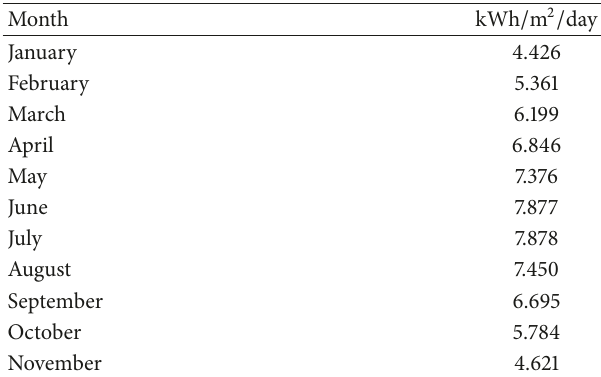
Table 2: Monthly averaged insolation incident (kWh / m 2 / day) in Libya.